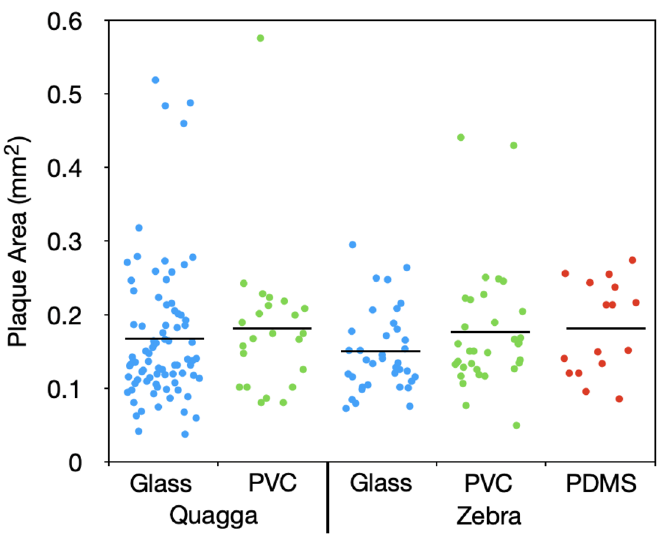
Figure 2. The area of quagga and zebra mussel plaques on glass, PVC, and PDMS. There was no significant difference in plaque areas for each material across the two